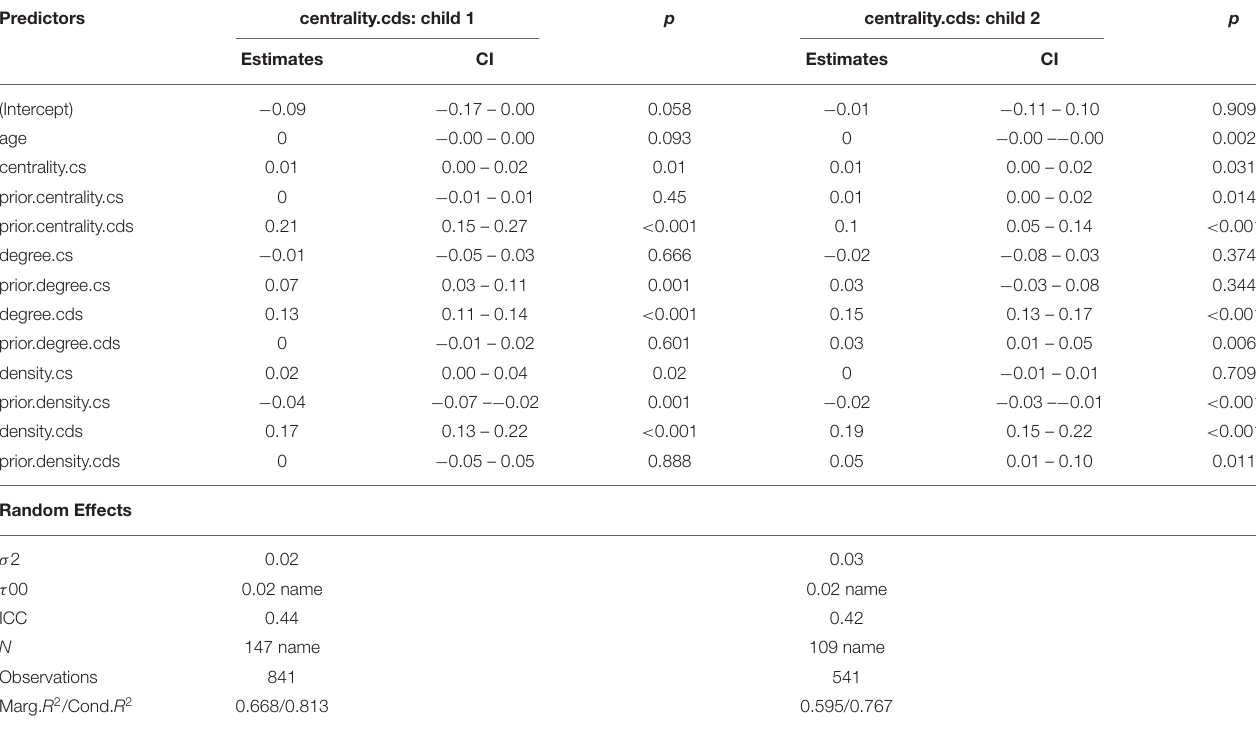
TABLE 9 | Linear mixed model: CDS node